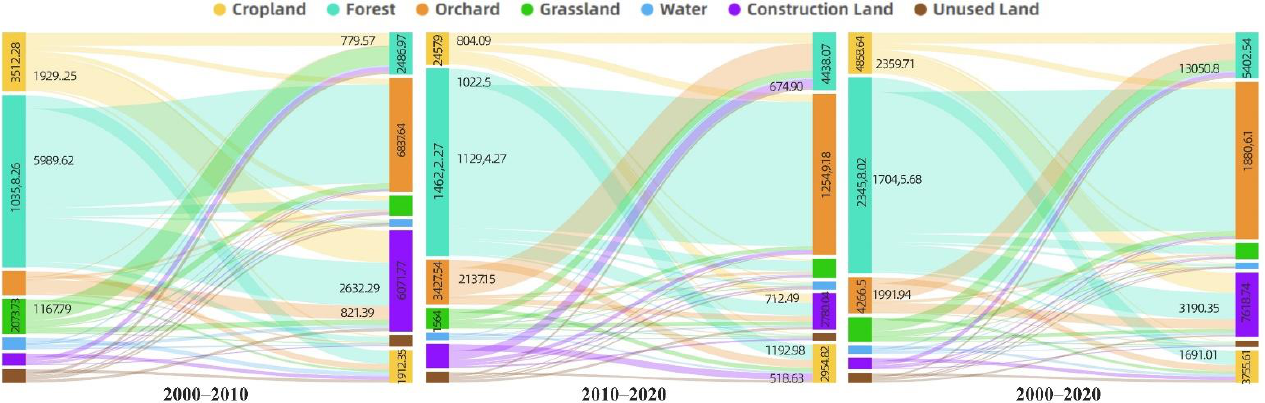
Figure 5. Land use transfer Sankey map. During the period of 2000 to 2010, the area of forest and cropland decreased signifi- cantly while the area of orchard and construction land increased substantially. As the main outflow type, the forest mainly transferred into orchard, construction land and cropland and the quantity was 10,358.26 hm 2 with a proportion of 57.8%, 25.4% and 7.75%, respectively. The area of cropland transferred out was 3512.28 hm 2 , 54.9% into construc- tion and 22.2% into forest. The inequality between outflow and inflow of cropland re- sulted in its total area decline. Orchard land increased by 6837.64 hm 2 with the 87.6% pro- portion came from forest and was the main inflow type. Construction land increased by 6071.77 hm 2 , mainly from forest land and cropland. During the period of 2010 to 2020, the land transfer trend was similar to that of the previous decade, but the expansion rate of orchard accelerated with an increment of 12,549.18 hm 2 including 11,294.27 hm 2 transferred from forest. A total of 2780.04 hm 2 of construction land formed mainly transferred from forest land and cropland with the pro- portion of 36.8% and 25.6%, respectively. Compared with the 6071.77 hm 2 of the previous decade, this transfer rate moderated noticeably due to the depletion of mineral resources. Meanwhile, 1828.2 hm 2 of construction land mainly transferred out into forest and cropland, 674.9 hm 2 and 518.63 hm 2 , respectively.